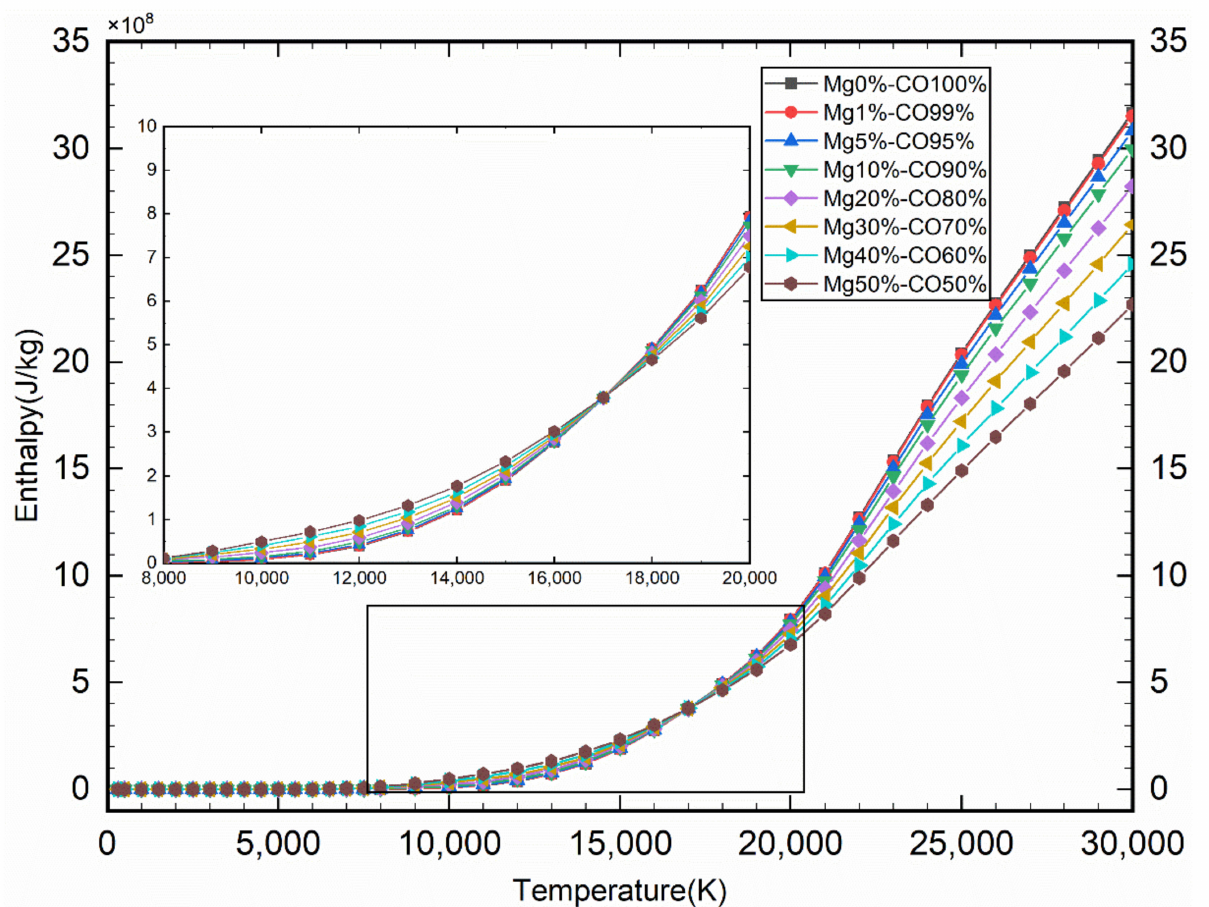
Figure 9. The curves of enthalpies for different proportion Mg-CO mixtures plasma at a temperature of 300–30,000 K and 0.1